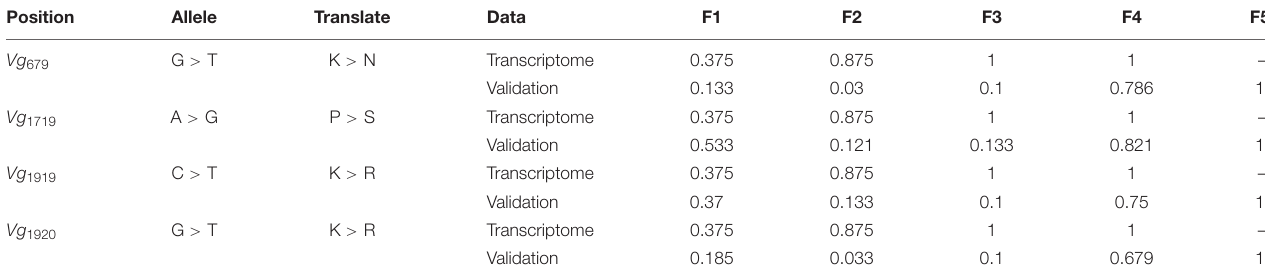
TABLE 1 | Single nucleotide polymorphisms (SNPs) in vitellogenin ( Vg ) and their allele frequencies from F1 to F4 (or F5). Position Allele Translate